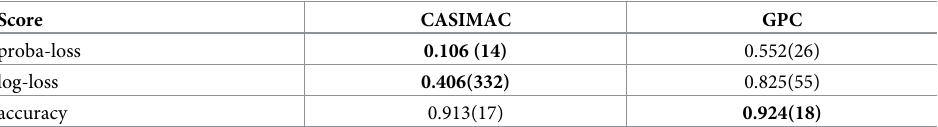
Table 1. Synthetic data test scores. Test scores for the synthetic data set based on T = 10000 uniformely sampled test datapoints. The proba-loss is defined in (44). We show the means and the corresponding standard deviations (in brack- ets) over all 10 classification tasks. The best mean results are highlighted in